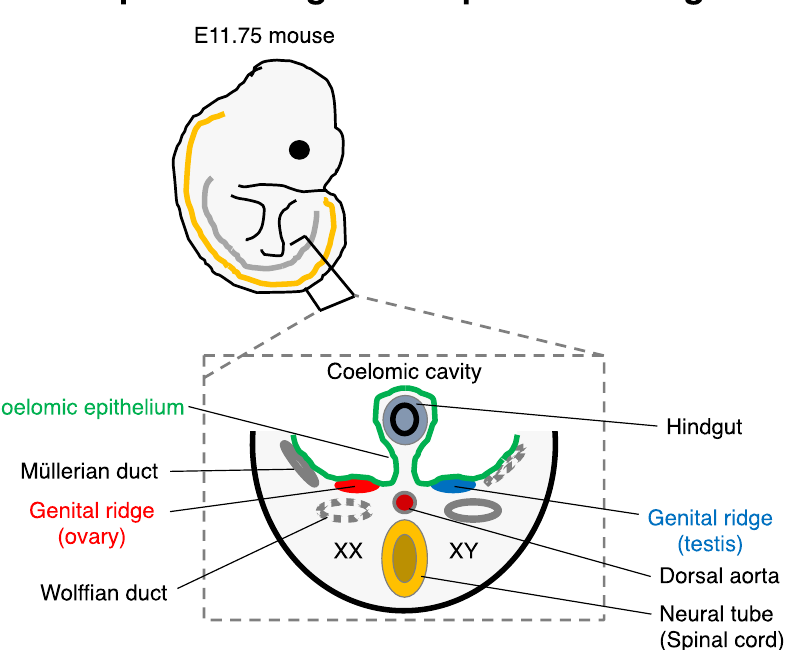
Figure 4. Developmental origins of reproductive organs. For example, E11.75 mice ( top ) is shown. The curved orange and gray lines show the spinal cord and the dorsal ridge of the coelomic epithelium. In a representative transverse section of the E11.75 mice ( bottom ), both female (XX; left ) and male development (XY; right ) are